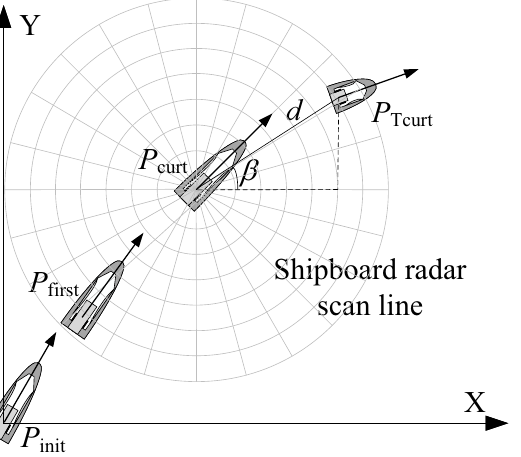
Figure 1. Coordinate systems for target parameterization with radar sensor